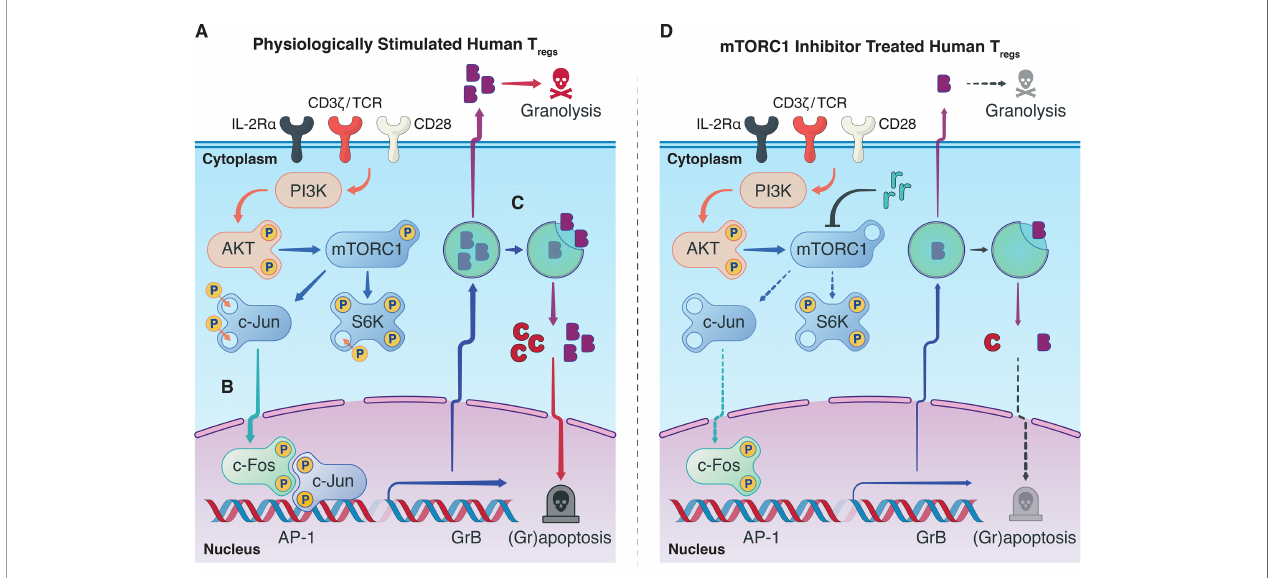
FIGURE 4 | Observed interplay between mTORC1 and GrB pathways. (A) In a physiological setting, antigenic T reg stimulation via the T-cell receptor, co-stimulatory CD28-based activation, and IL-2R a (CD25)-dependent cytokine signaling, sets in motion a phosphorylation cascade involving phosphoinositide 3-kinase (PI3K), Akt, mTORC1, S6 kinase 1 (S6K), and c-Jun. Phosphorylated c-Jun is known to permit its nuclear translocation where it can undergo dimerization with p-c-Fos and generate transcription factor Activator Protein-1 (AP-1). (B) Our hypothesis is that AP-1 can unwind heterochromatic DNA in the promotor region of GrB in T regs to boost the transcription of GrB mRNA. Conventionally, upon mRNA translation, the mature GrB proteins are stored in designated cytotoxic granules to save their potent cytolytic activity for target effector T cells. (C) In the context of protracted antigenic stimulation, however, GrB can inadvertently leak from its harboring lysosomes to precipitate caspase-dependent and independent cell death. (D) Treatment of T regs with mTORC1 inhibitors such as rapamycin provide a multipronged effect, notably, decreasing phosphorylation of p-S6K and p-c-Jun, attenuating GrB expression and activity, and fi nally diminishing T reg apoptosis. The exact biochemical constituents that drive this phenotypic and functional shift in the T reg population upon mTORC1 inhibition remain to be elucidated and warrant further research